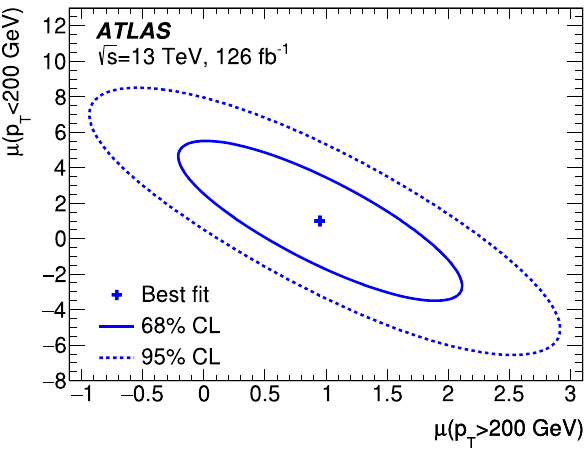
Fig. 8 Likelihood scan as a function of the signal strength for VBF Higgs boson production versus the signal strength for ggF Higgs boson production. Shown is the best-fit value (blue plus sign), and the 68% (solid blue) and 95% (dashed blue) confidence level (CL) contours. The asymmetric shape arises from the fit’s inability to separately constrain the subset of ggF events which have a VBF-like